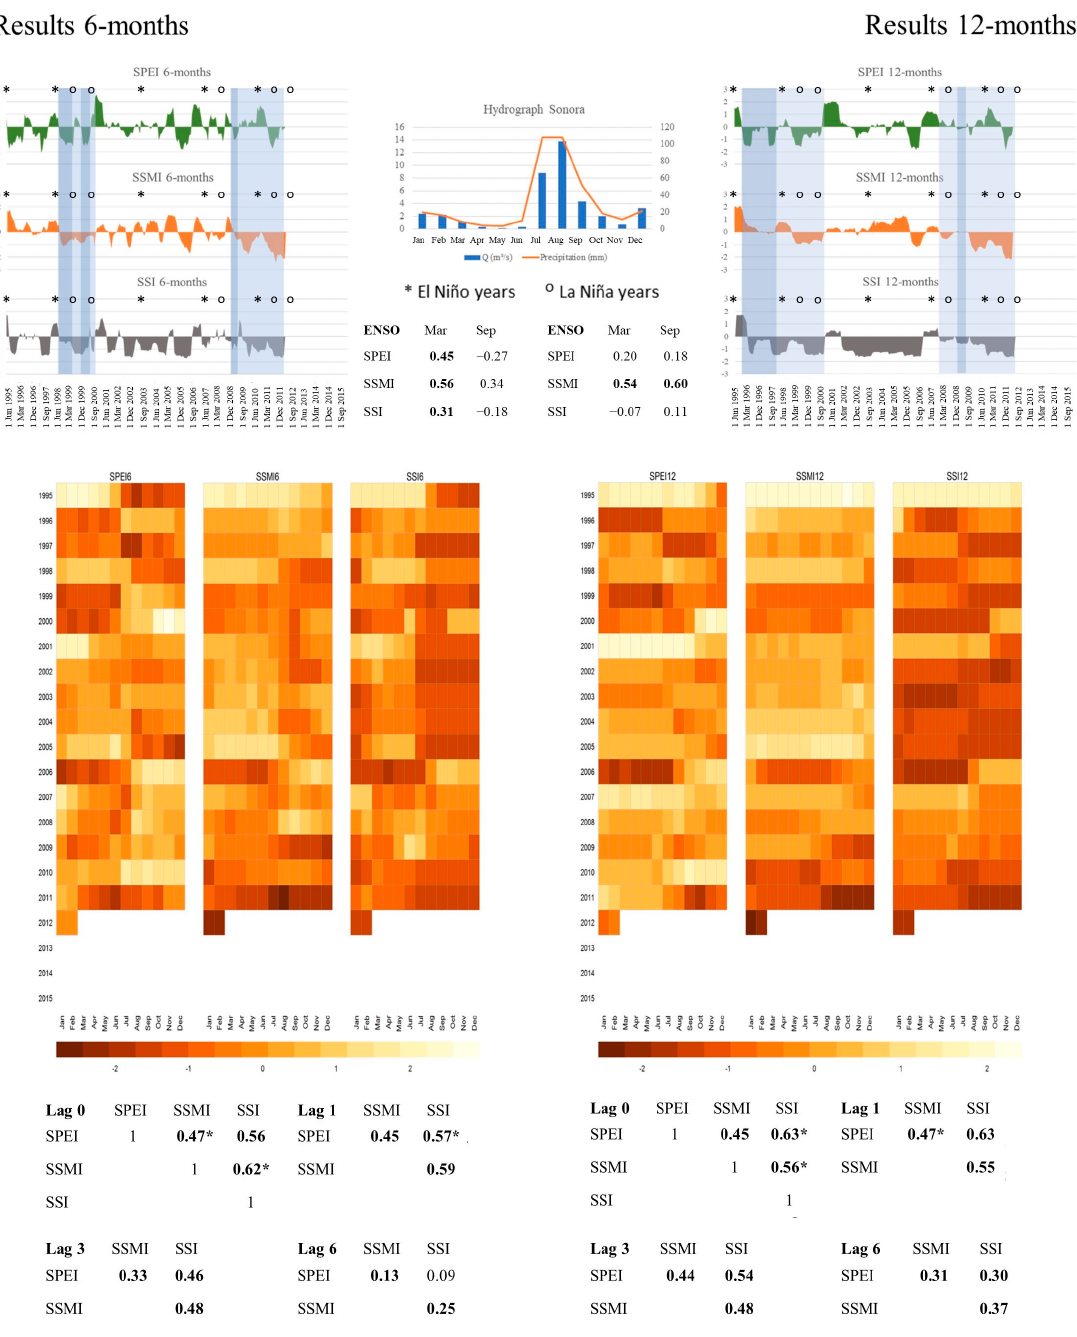
Figure 4. Graphical summary of results for the Sonora river basin.